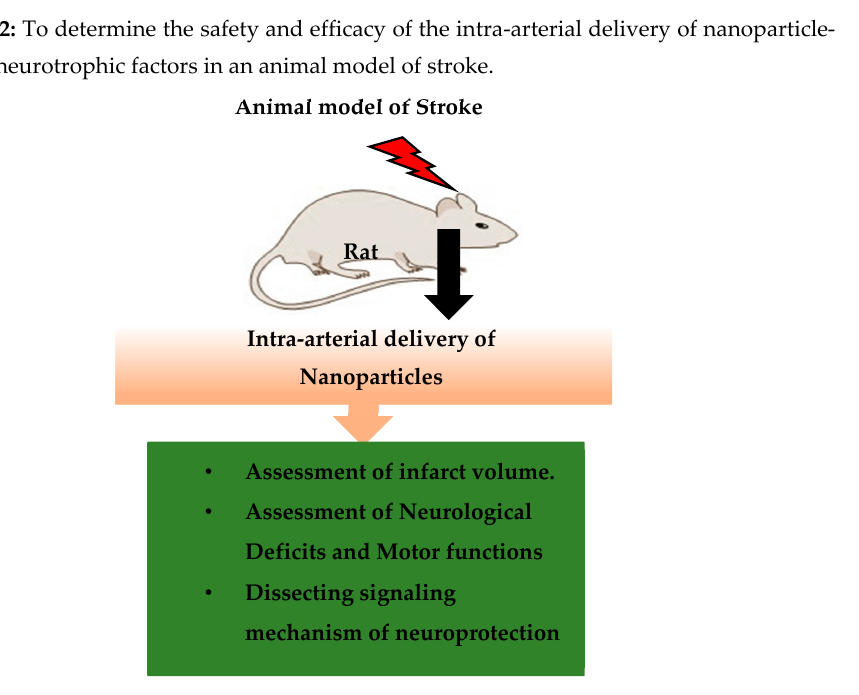
Figure 5. The vision for our future research.